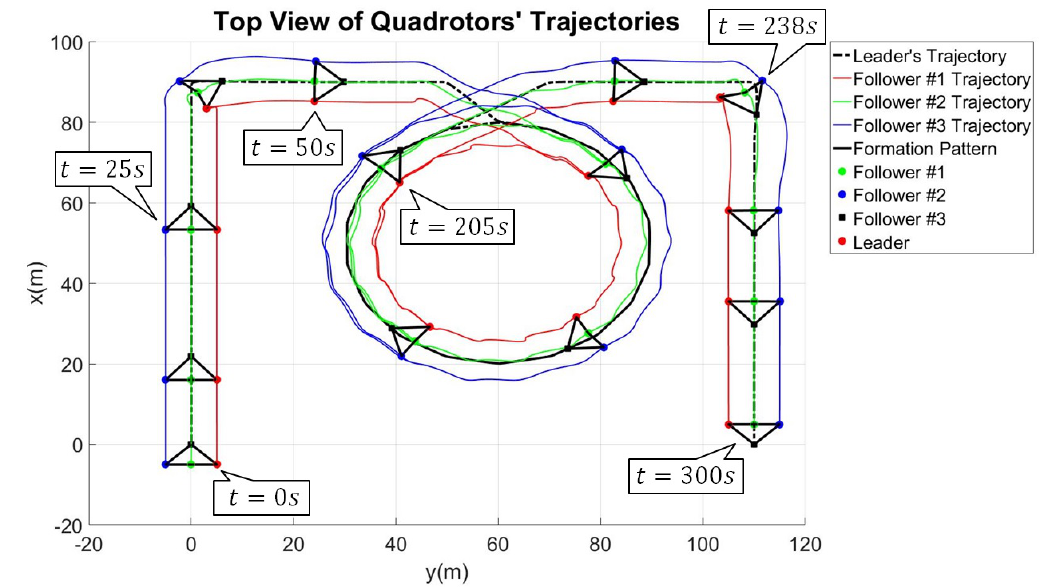
Figure 14. Top view of quadrotor trajectories throughout the comprehensive maneuver.